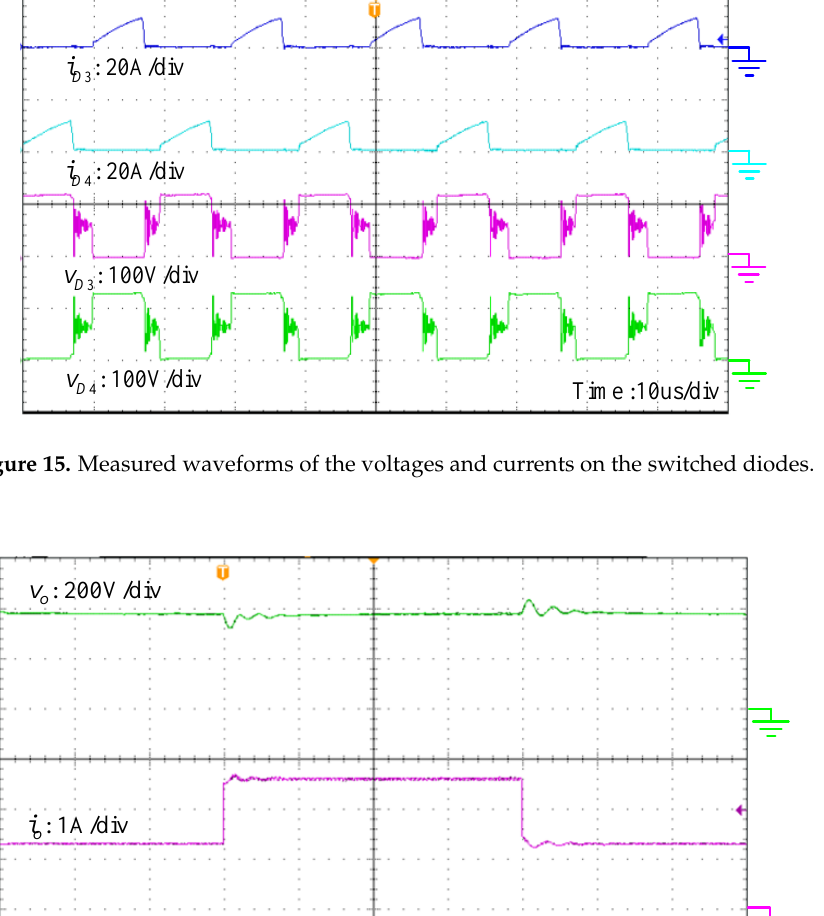
Figure 14. Measured waveforms of the voltages and currents on the output diodes.